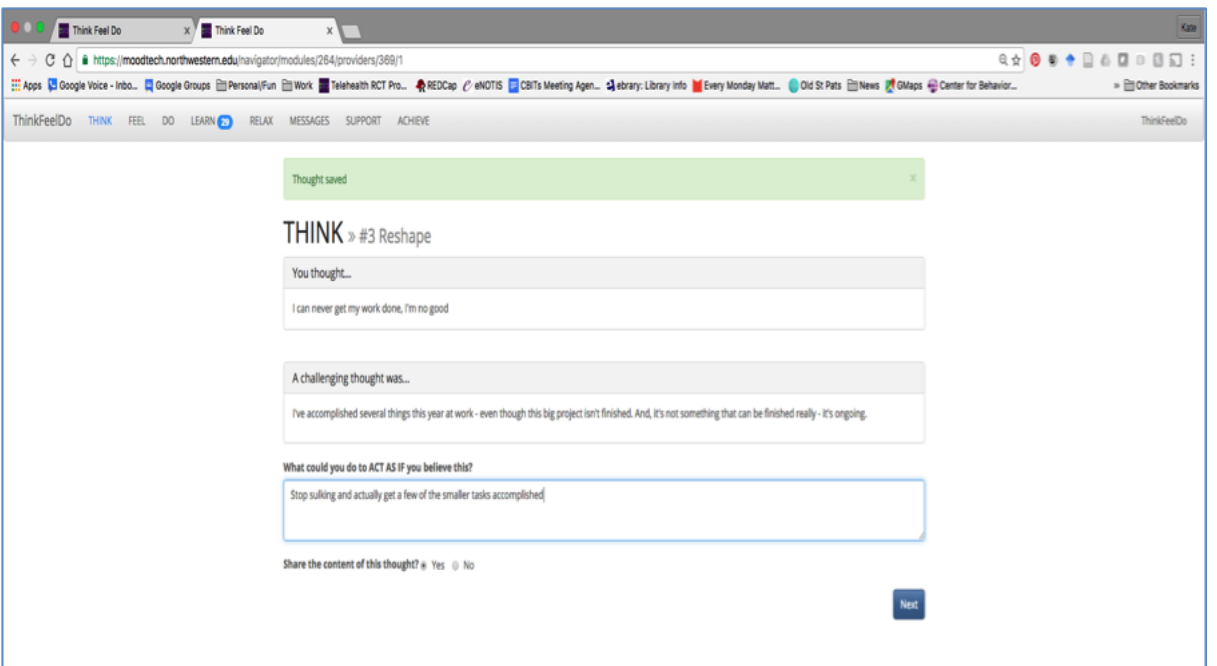
Figure 1. Screenshot of harmful thoughts activity. Participants enter thoughts and create a challenging thought and action in response. The thoughts can be private or shared publicly with the peer support group, allowing peer and coach comments.